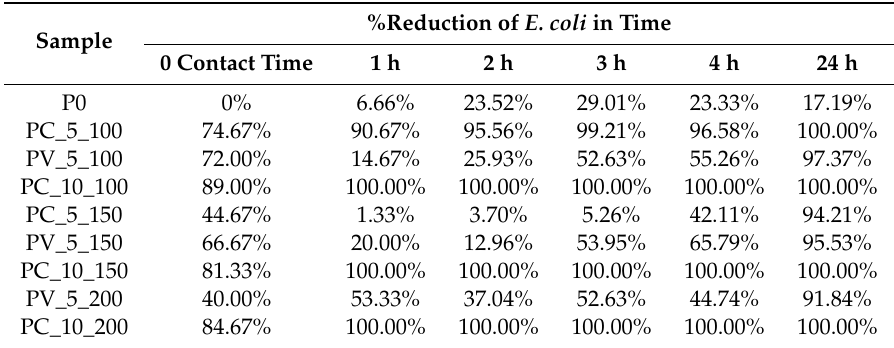
Table 1. Inhibition e ff ect of the nanofiber / NPs-coated yarn in time.